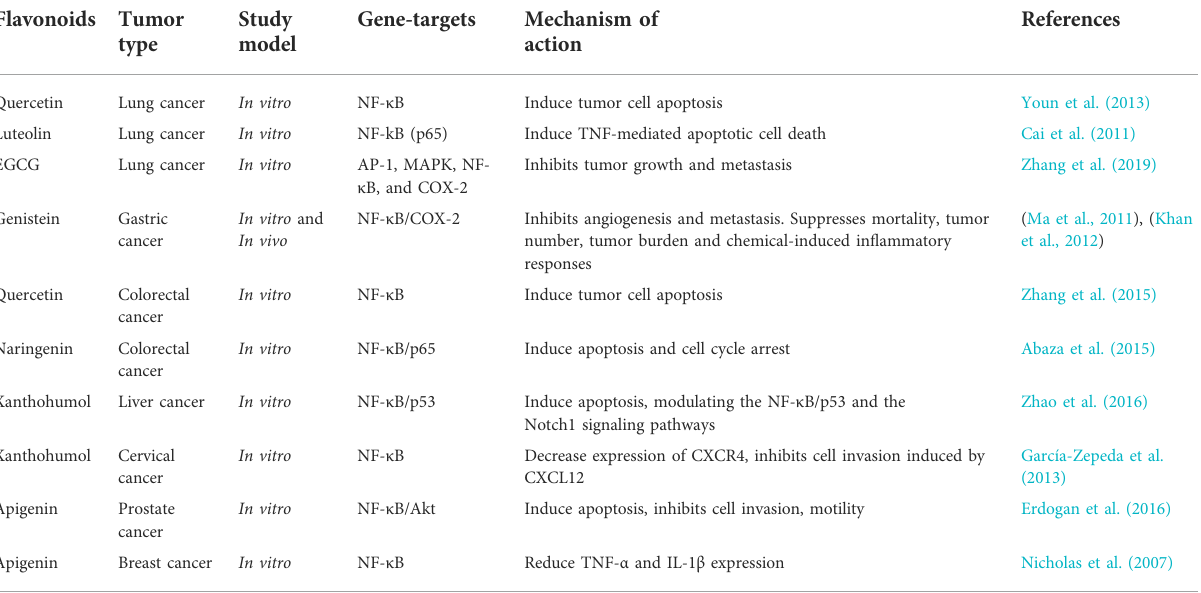
TABLE 4 The antitumor effects of fl avonoids through control the expression in fl ammation